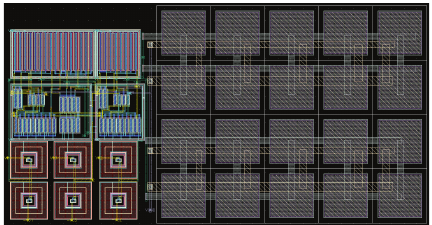
Figure 4: The core of the proposed current-mode universal biquad- ratic filter.